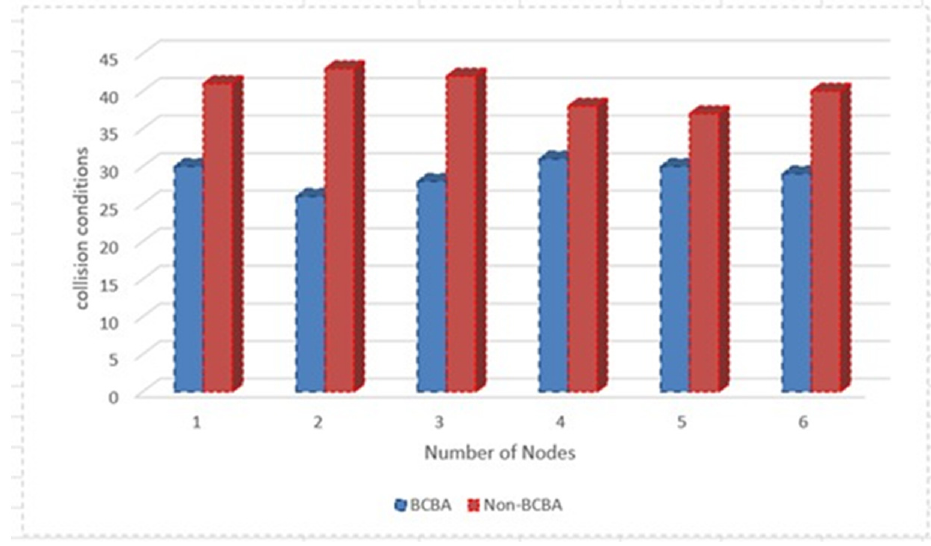
Figure 7. Comparison of non-blockchain and blockchain-based technique collision ratio. Table 2. Performance metrics